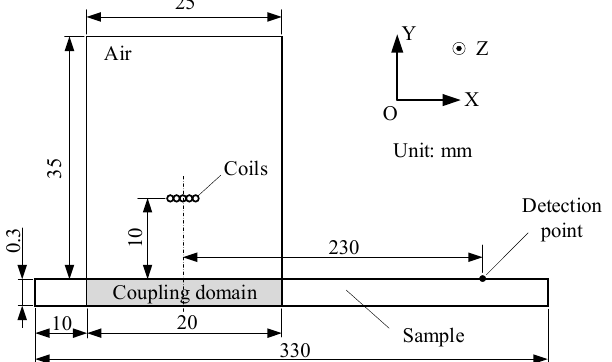
Figure 3. The geometry of the two-dimensional (2-D) finite element (FE) model used to simulate the ultrasonic generation by the magnetostriction-based EMAT.